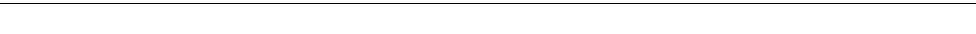
Table 1. Programs, Systems, and Initiatives Addressed Through Rural Food Access Working Group (RFAWG) Participants’ Policy Research (listed in order from most to least common) Program, Systems, or Initiative